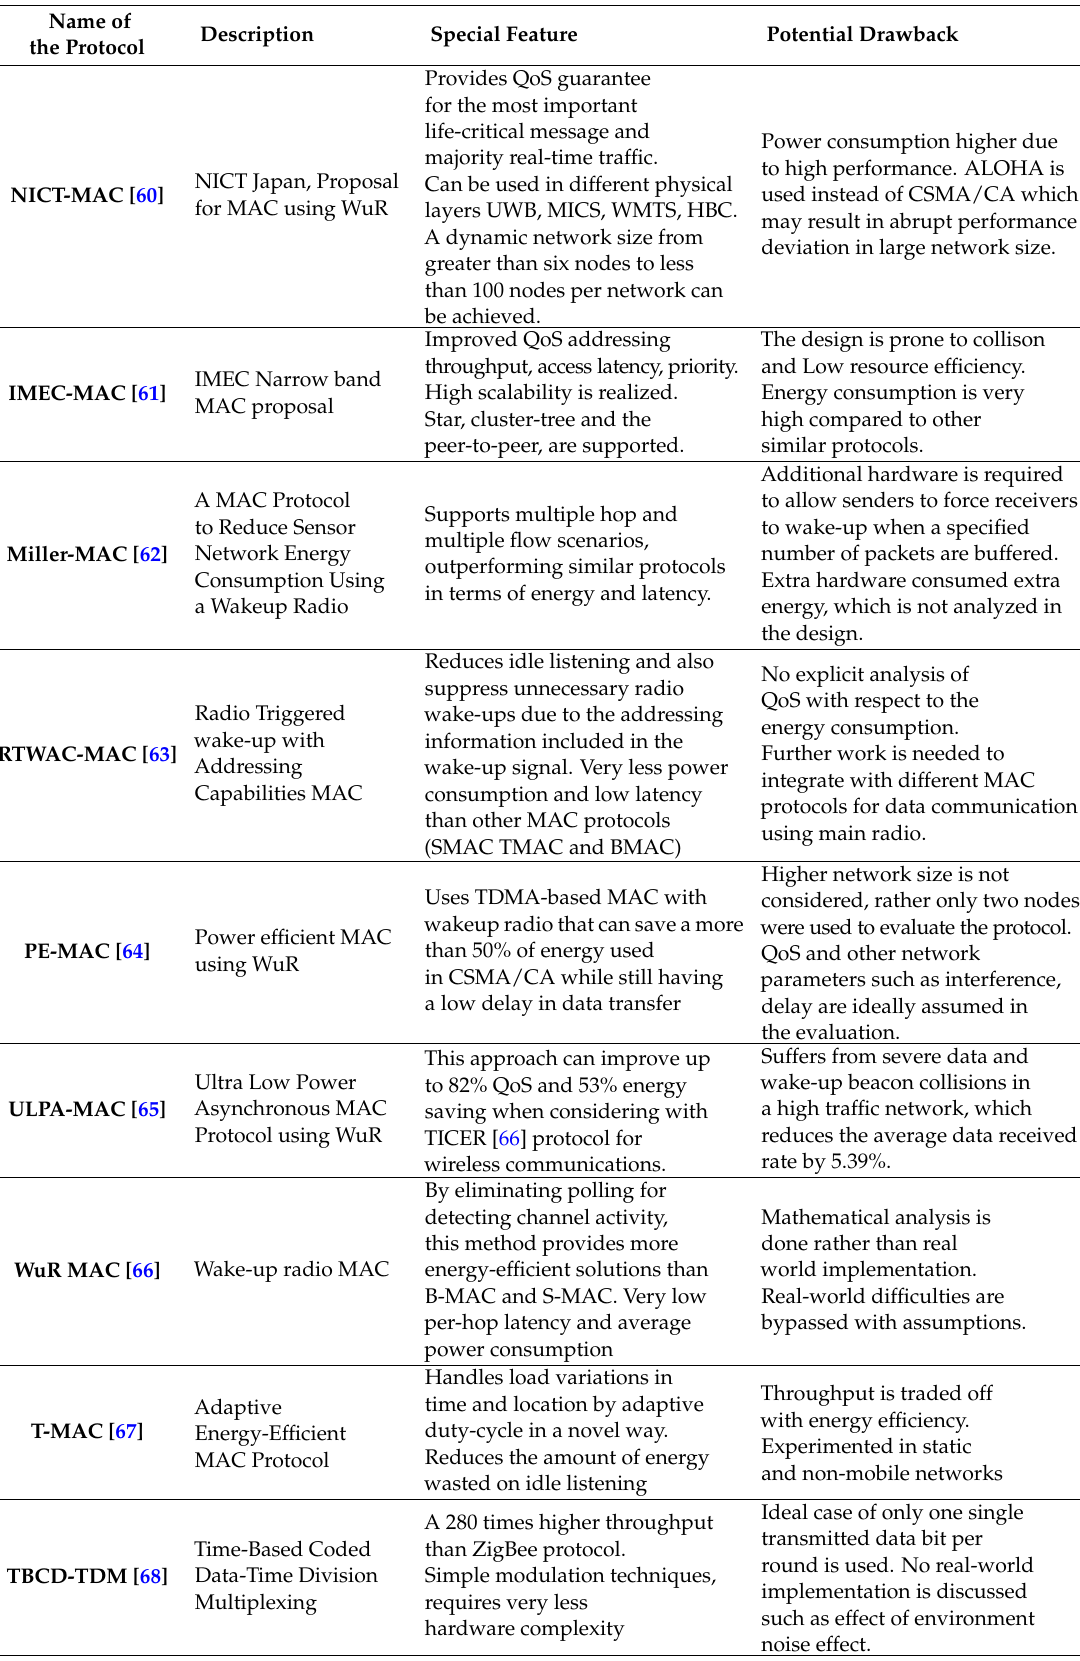
Table 10. MAC protocols with WuR and their drawbacks for